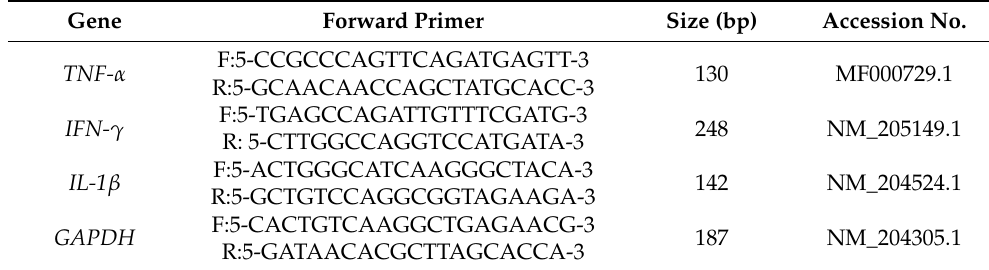
Table 1. Primer sequences and anticipated size of amplified products.